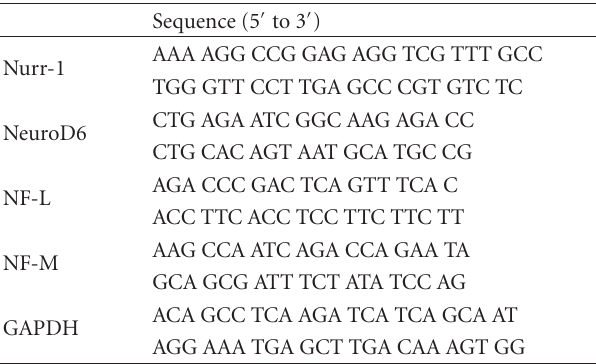
Table 1: Sequences of the RT-PCR